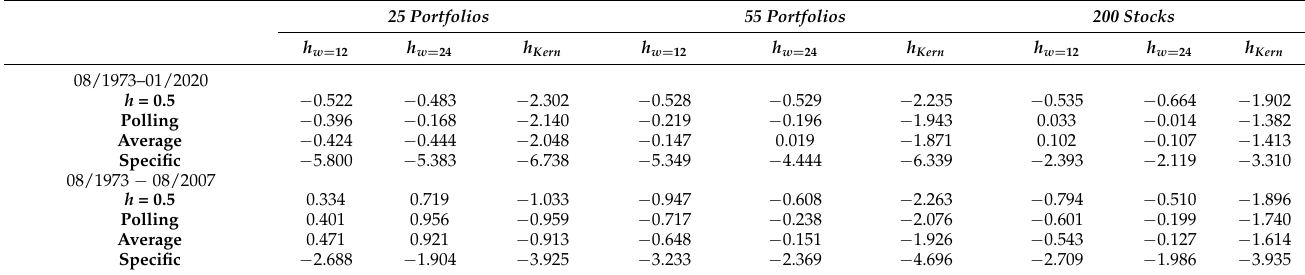
Table A2. Percentage reduction in RMSEs for different sample.